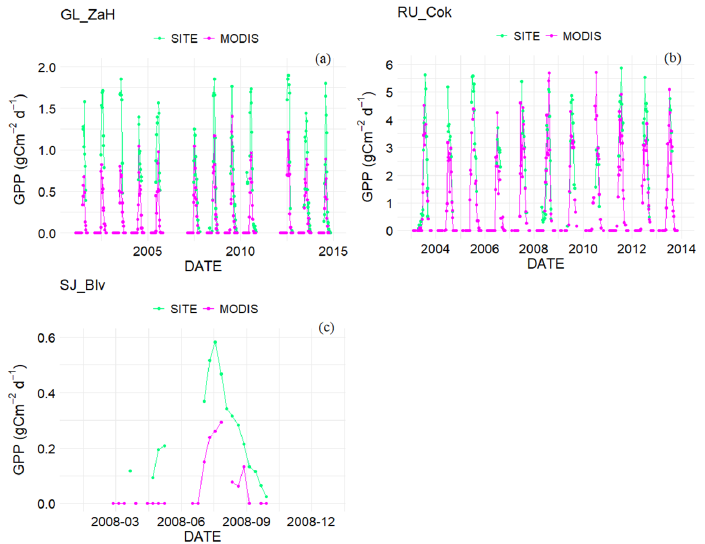
Figure 6. Time series comparison between site-based GPP and MOD17A2H over grasslands ( a ), shrublands ( b ), and permanent snow and ice ( c ) sites.